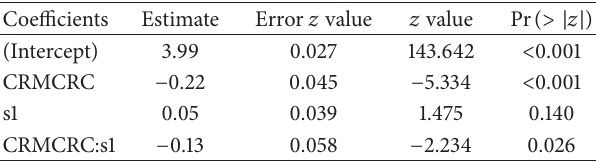
Table 1: The interactions between these terms and status are demonstrated. Only the sine curve with period of 1 year and its interaction with status were